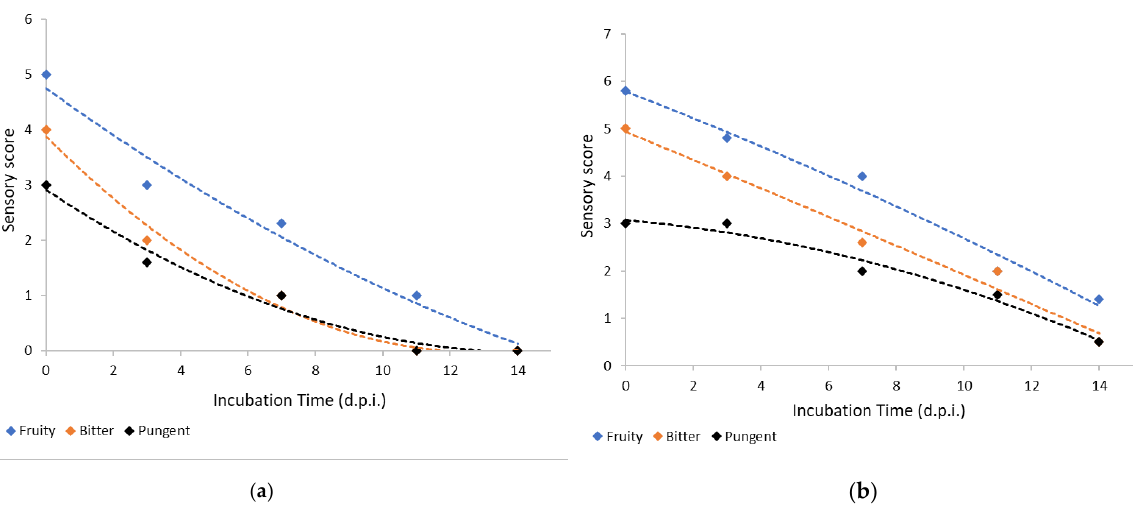
Figure 5. Sensory scores for positive (fruity, bitter, and pungent) attributes detected in Galega ( a ) and Cobrançosa VOO ( b ) obtained from fruits, at times 0, 3, 7, 11, and 14 days post-inoculation (d.p.i.) with Colletotrichum acutatum.